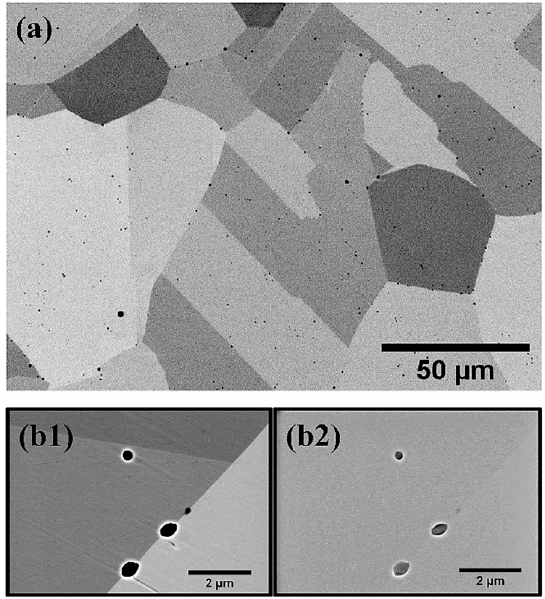
Figure 12. Oxide inclusions in the fully-recrystallized additive manufacturing (AM) AISI 316L stainless steel: ( a ) low magnification back-scattered electron image; ( b1 ) high magnification back-scattered electron image; ( b2 ) high magnification secondary electron image [75].